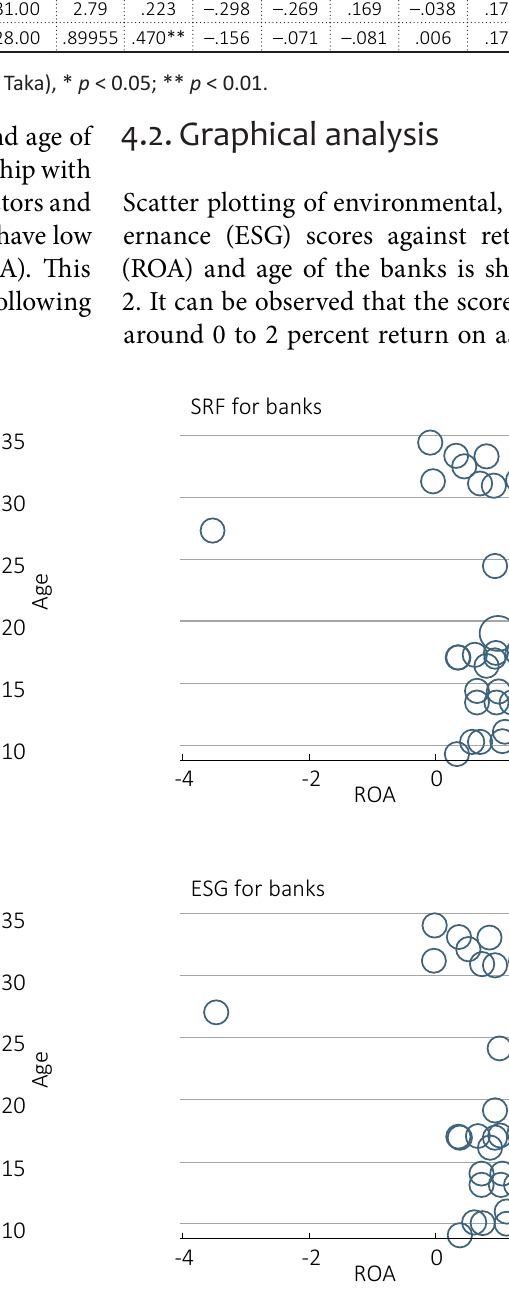
Figure 2. Scatter plotting of ESG scores with ROA and